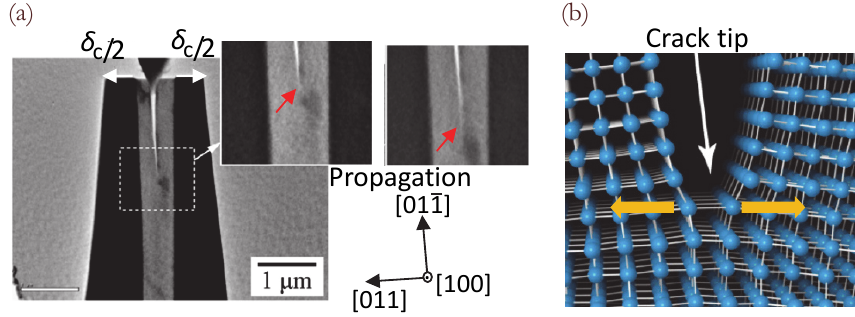
Figure 4: TEM image of (a) crack propagation of specimen 2 and (b) fracture mode displacements at the onset of